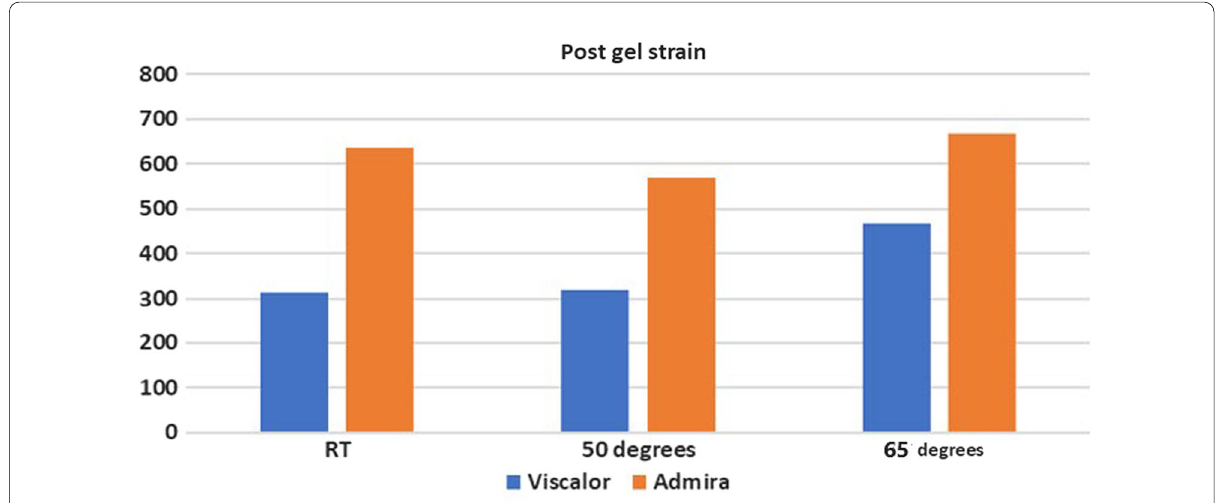
Fig. 2 A bar chart illustrating the effect of preheated different resin composite restorative materials on post-gel polymerization shrinkage strain